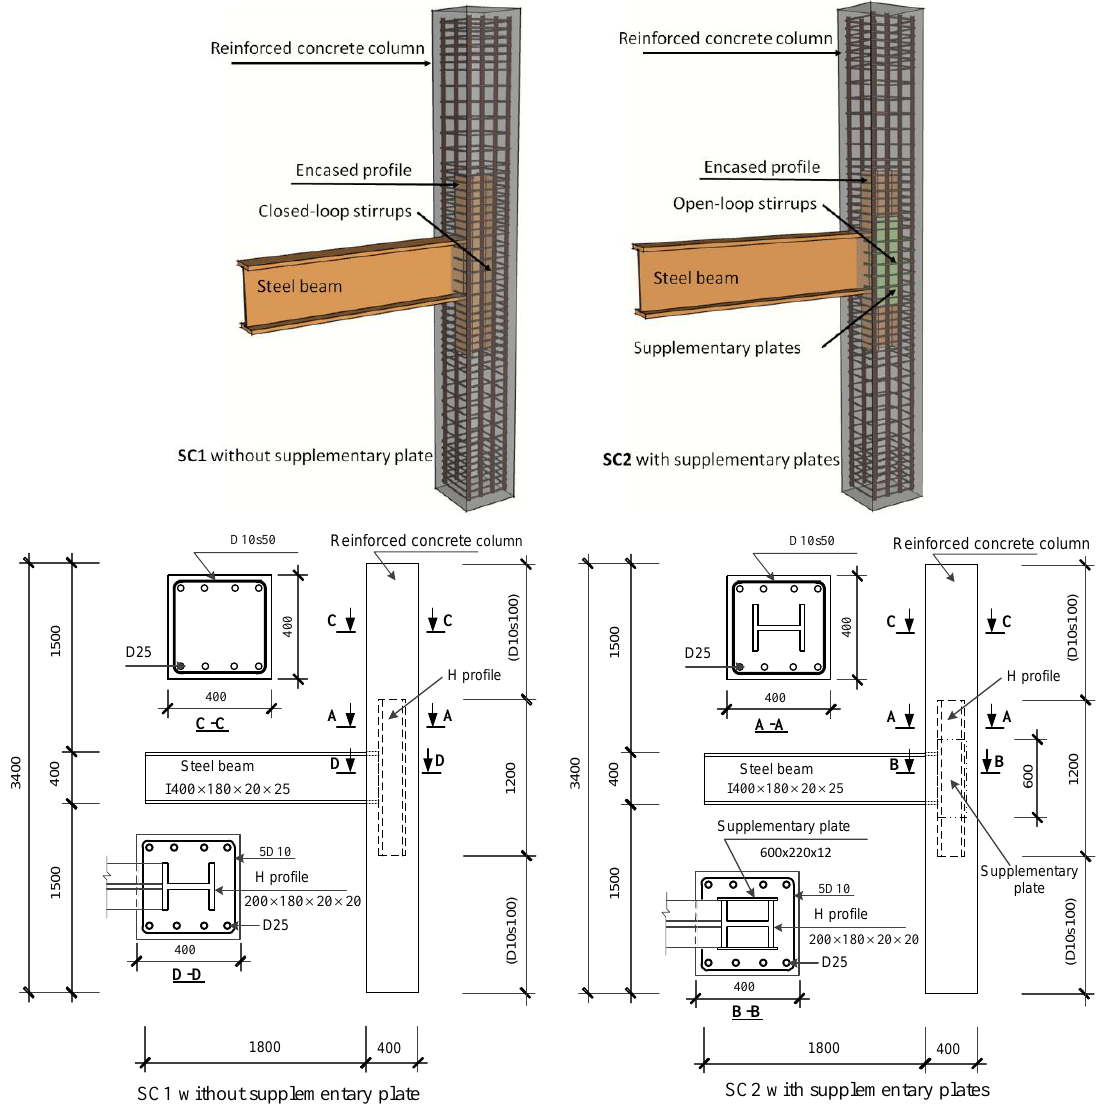
Figure 2. Description of the test specimens.